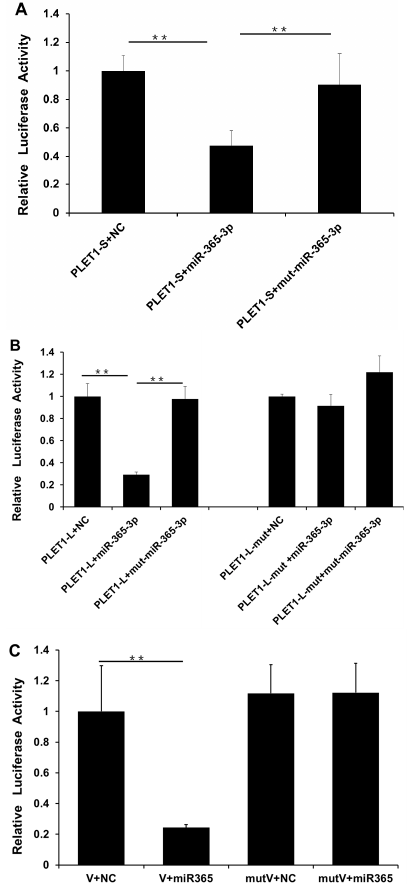
Figure 7. Validation of the interaction between miR-365-3p and PLET1 3 ′ UTR by luciferase assay. ( A ) Luciferase assay of cells transfected with PLET1-S luciferase vectors. PLET1-S: luciferase vector of the full length of PLET1-S 3 ′ UTR; mut-miR-365-3p: miR-365-3p mutant; ( B ) Luciferase assay of cells transfected with PLET1-L and PLET1-L-mut luciferase vectors. PLET1-L: luciferase vector of the full length of PLET1-L 3 ′ UTR; PLET1-L-mut: luciferase vector of PLET1-L 3 ′ UTR carrying mutant miR-365-3p binding site; ( C ) Luciferase assay of cells transfected with the truncated PLET1-L 3 ′ UTR luciferase vectors that contains the predicted binding site or mutated binding site. V: the truncated PLET1-L 3 ′ UTR (26 bp) luciferase vector containing the miR-365-3p seed binding site; mutV: mutant vector of the truncated PLET1-L 3 ′ UTR fragment (26 bp) containing the mutated seed binding site. Data are shown as mean ± SEM of three independent experiments. The significance of differences was calculated using two-tailed t -test. ** p < 0.01.